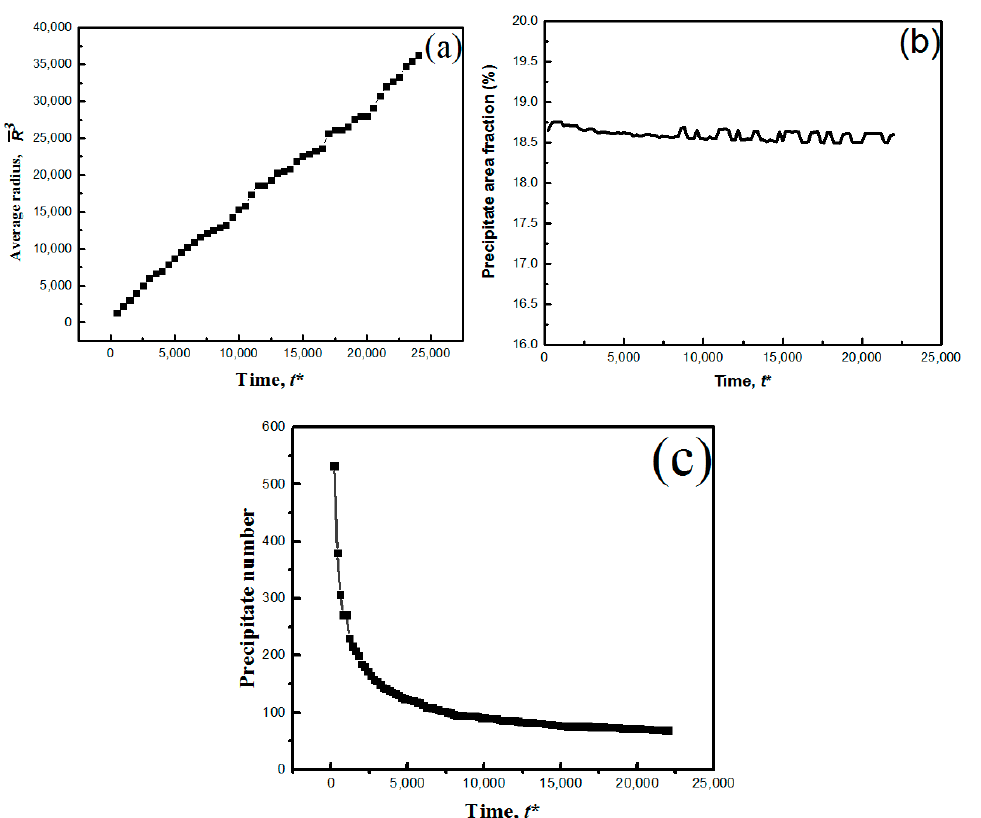
Figure 3. ( a ) Plots of the cube of the average precipitate radius with time in absence of nanoparticles, ( b ) the change in precipitate area fraction with time in absence of nanoparticles, and ( c ) the change of precipitate numbers with time in absence of nanoparticles in the system.